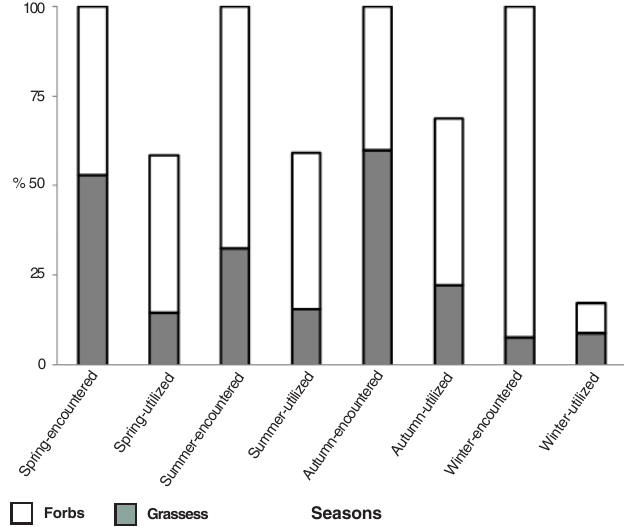
Figure 2. Seasonal differences in the forbs and grasses encountered and utilized by male Gazella subgutturosa marica (N=2) along foraging trails in central Saudi